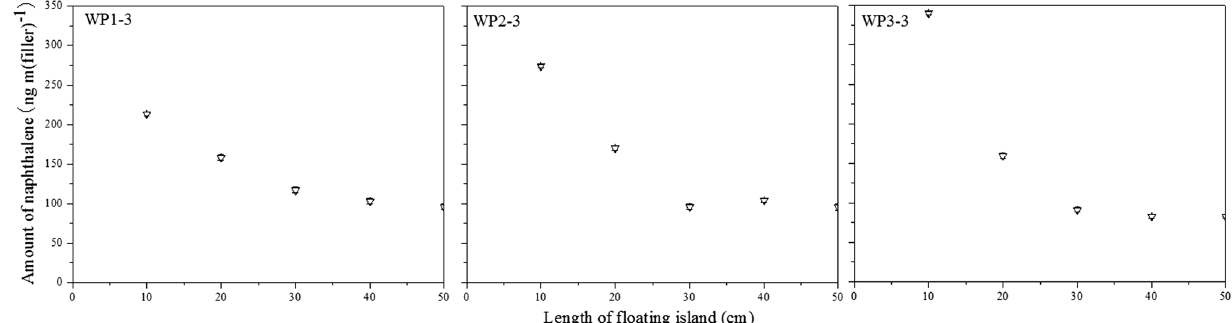
Fig. 3 Distribution amounts of naphthalene on the fillers with differ‑ ent colloids. Distribution amounts of naphthalene with humic acid colloids (WP1‑3), kaolin colloids (WP2‑3) and kaolin–humic acid compounded colloids (WP3‑3) were checked in different lengths of